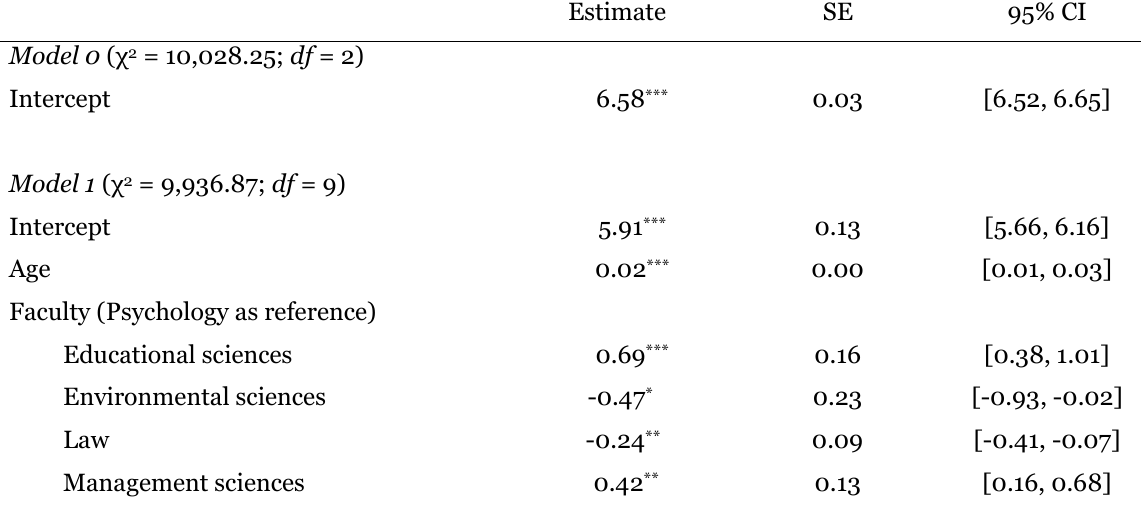
Fixed Effects for Models of the Predictors of Students’